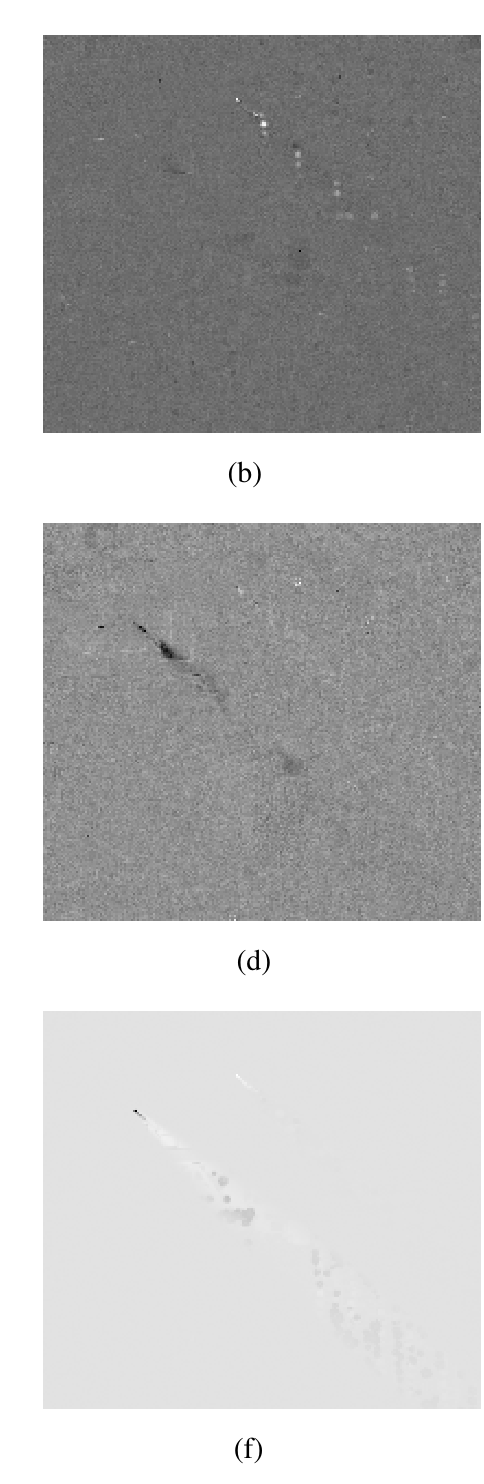
Figure 4. Images that show the BVD image detecting the (a) Freon plume in Channel 15 (scene-wide whitening) (b) Freon plume in Channel 35 (scene-wide whitening) (c) NH plume in Channel 37 (scene-wide whitening) (d) NH whitening) (e) Freon plume in channel 35 (background-only whitening) and (f) NH in channel 52 (background-only